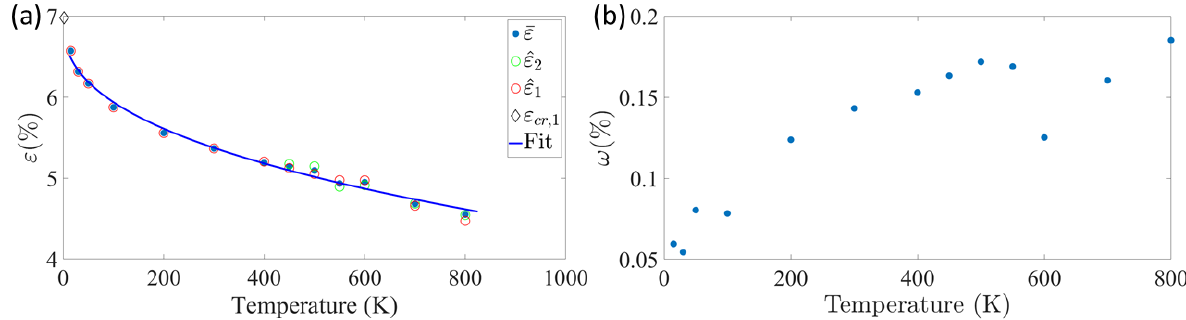
Figure 4. CDFs nucleate a dislocation as a function of the strain for different temperatures. The critical strain of the acute angle ε cr ,1 is marked in a dashed line.